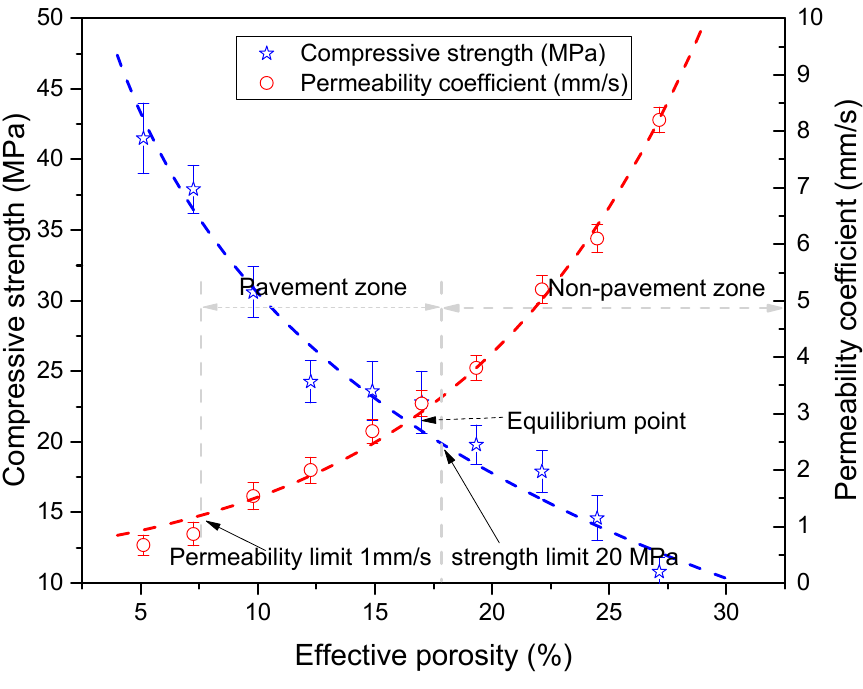
Figure 10. Equilibrium point of the compressive strength and permeability coefficient variation with effective porosity of the pervious concrete.